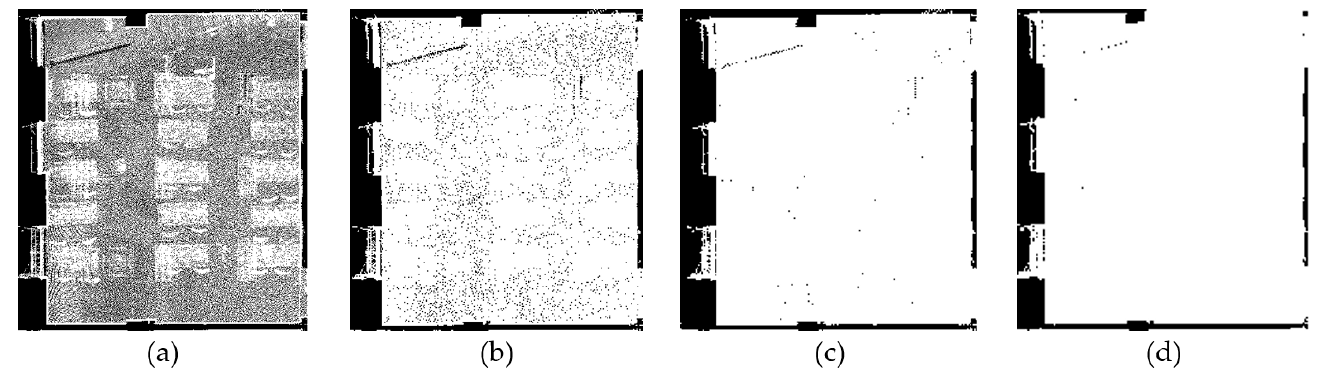
Figure 6. The binary mask images I 0 of a local indoor area (the top room in Figure 3a) using different pixel sizes ( k times average data spacing): ( a ) k = 1, ( b ) k = 1.5, ( c ) k = 2, and ( d ) k = 2.5.